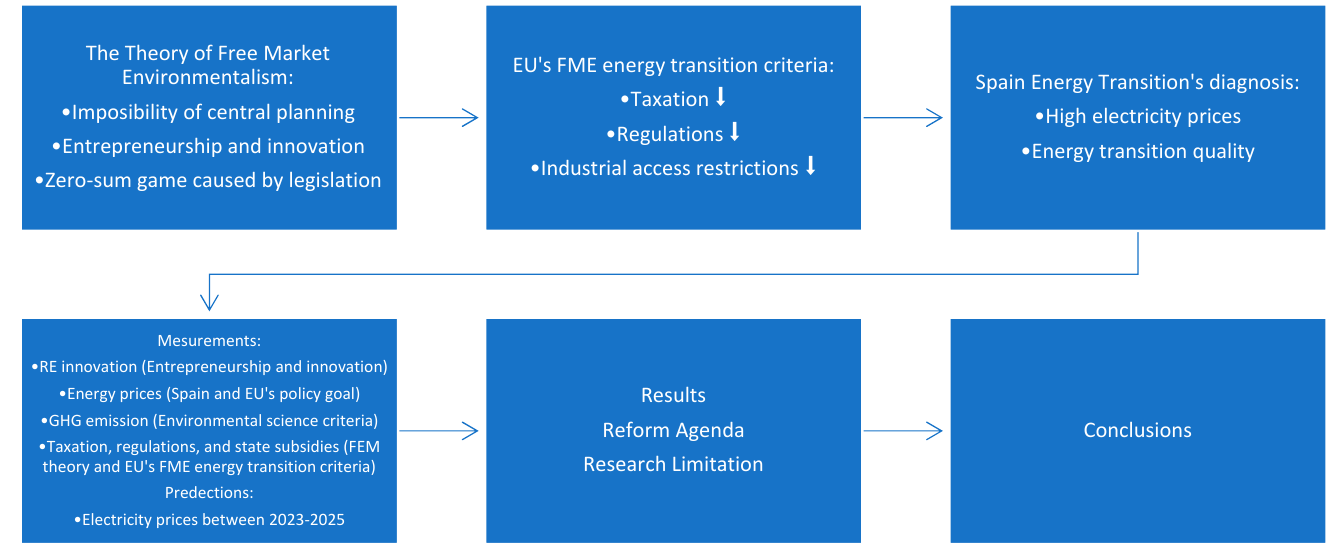
Figure 1. Research Figure 1. Research framework.